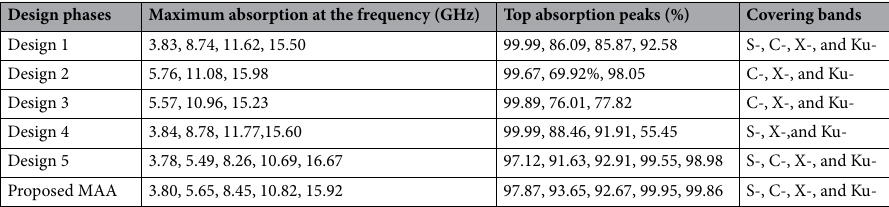
Table 2. Various design steps with related